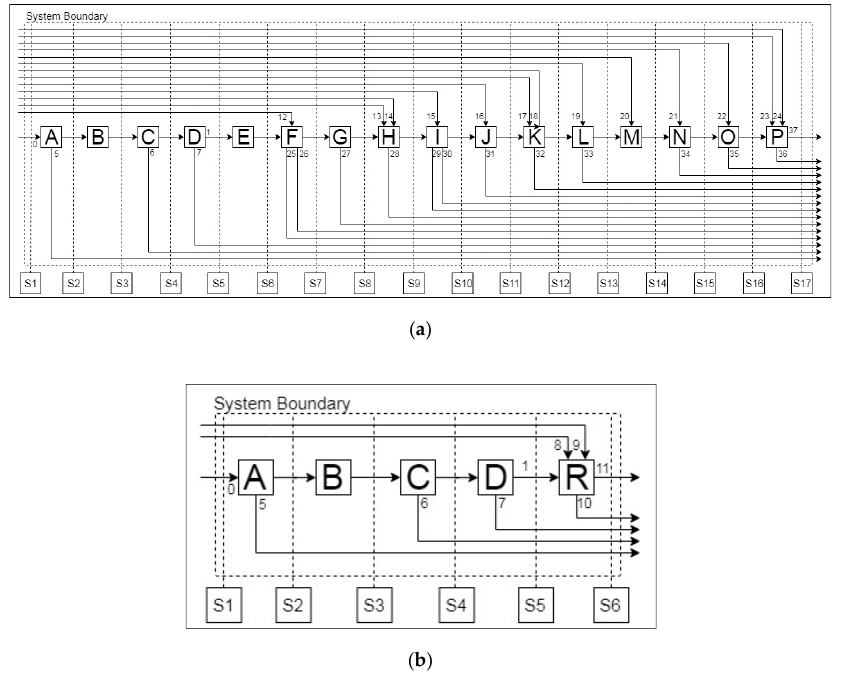
Figure 9. Electrode treatment ( a ) and Al-recovery ( b ) processes with pre-processing (PP) stages reported in the